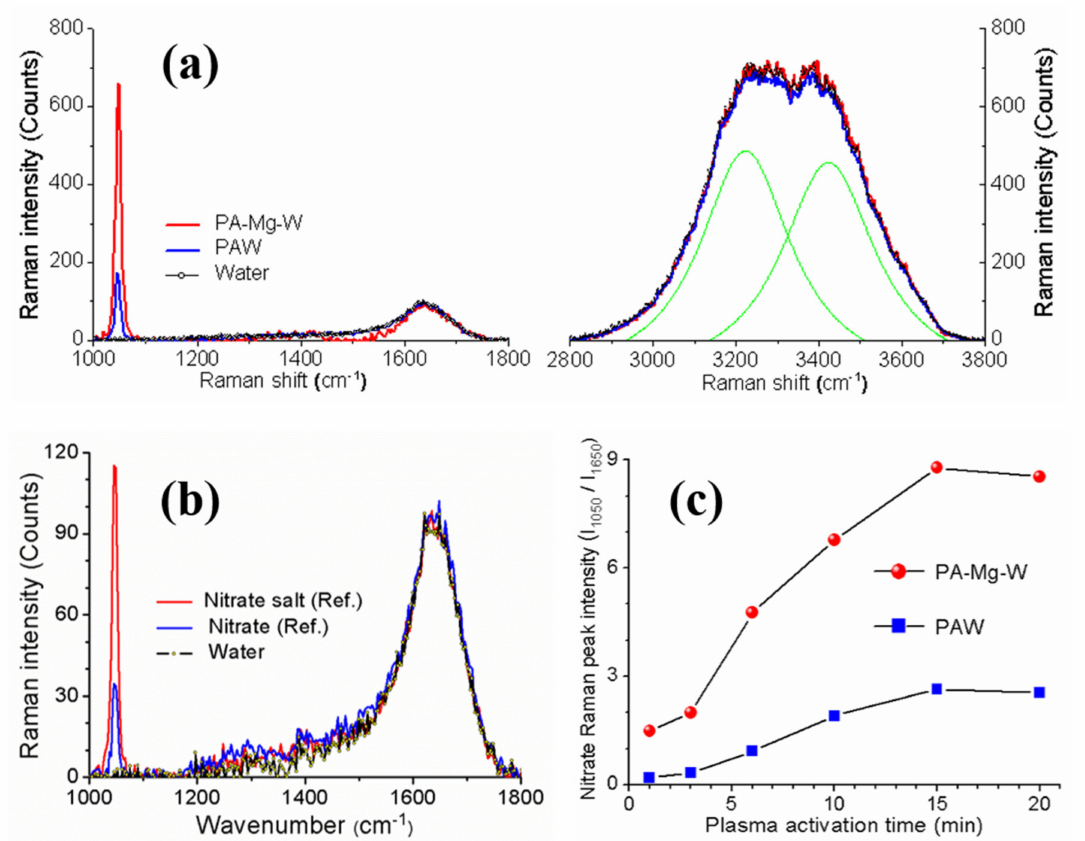
Figure 6. ( a ) Raman spectra of the PAW and PA-Mg-W. ( b ) Raman spectra of the reference free nitrate and nitrate salt solutions. ( c ) Nitrate Raman peak intensity as a function of plasma activation time. In ( a ), the Raman spectra were measured for PAW and PA-Mg-W treated by the plasma jet for 10